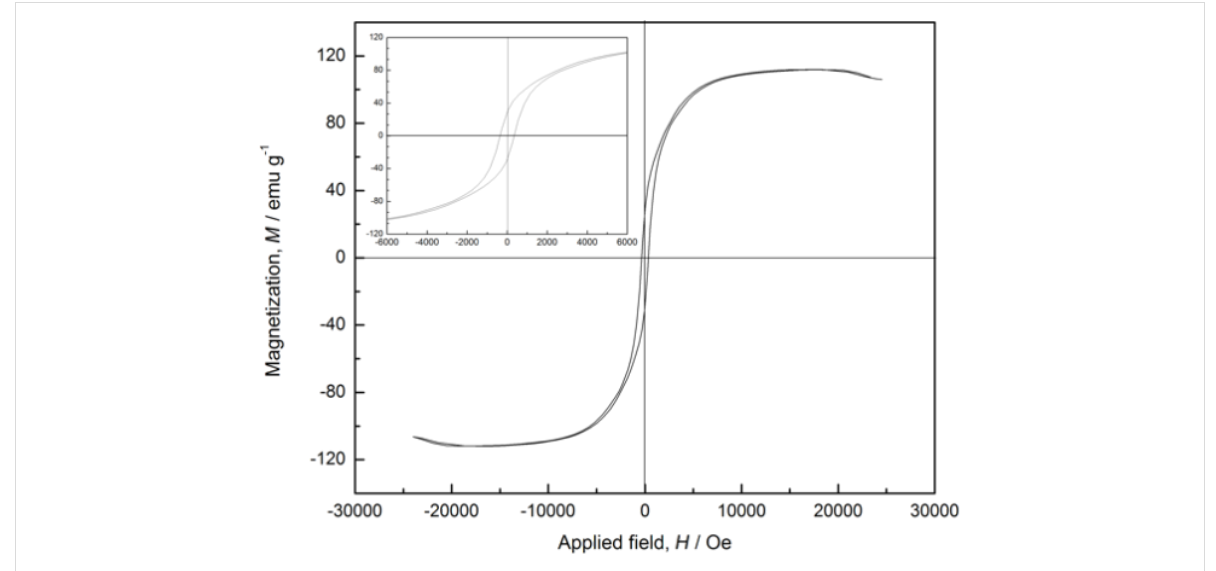
under an external magnetic field of 40 mT. An expanded plot is shown in the insert for field strengths between − 6000 Oe and 6000 Oe. The hysteresis loop suggested that the synthesized cobalt nanowires were ferromagnetic at room temperature, which differs from the superparamagnetic property exhibited in the previous report [13]. The coercivity ( H c ) of the cobalt nano- wires were 352.87 Oe, and the saturation magnetization ( M s ) were 112.00 emu g − 1 , which was lower than the corresponding value of bulk cobalt (162.5 emu g − 1 )